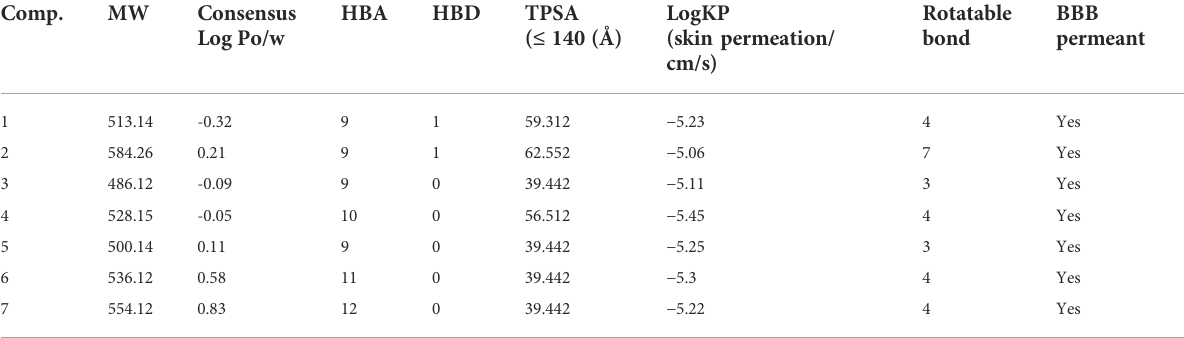
TABLE 5 Absorption and distribution properties of the synthesized complexes. Comp.